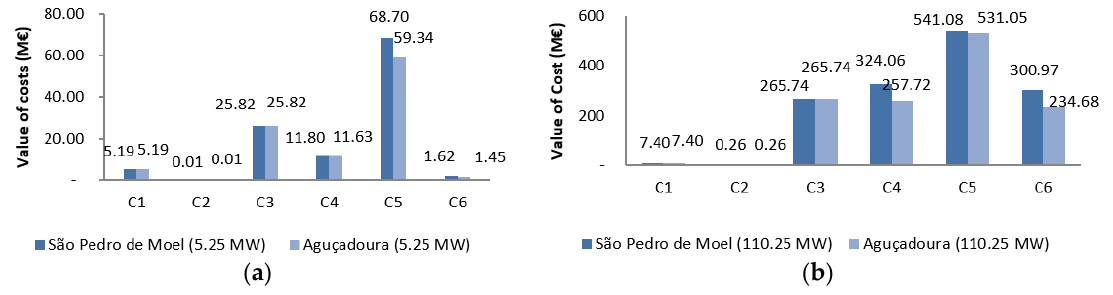
Figure 7. Life-cycle cost of ( a ) a 5.25 MW small wave farm and ( b ) a 110.25 MW big wave farm.